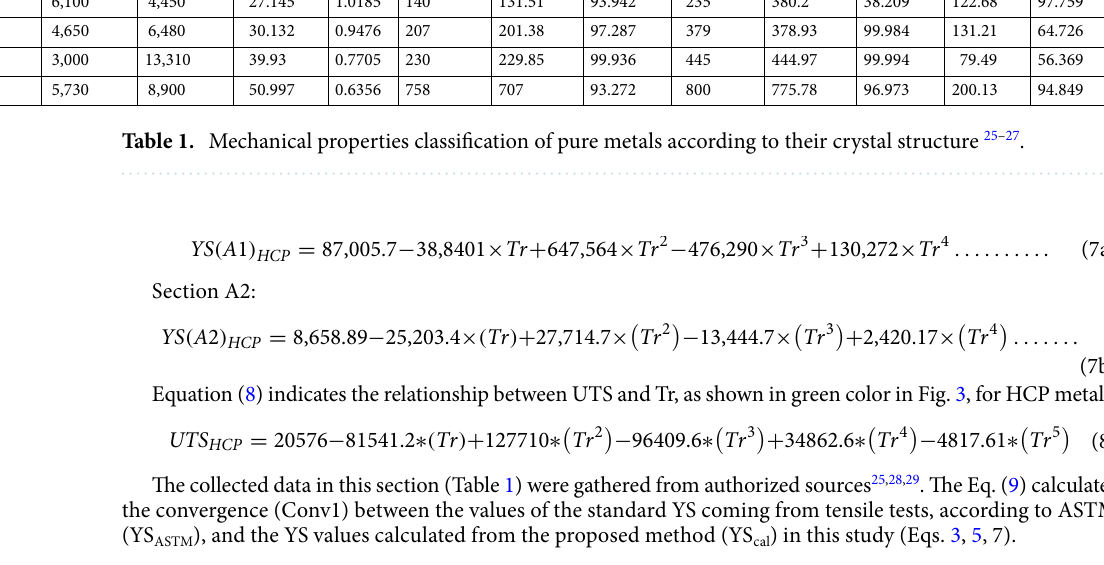
Equation (8) indicates the relationship between UTS and Tr, as shown in green color in Fig. 3, for HCP metals: